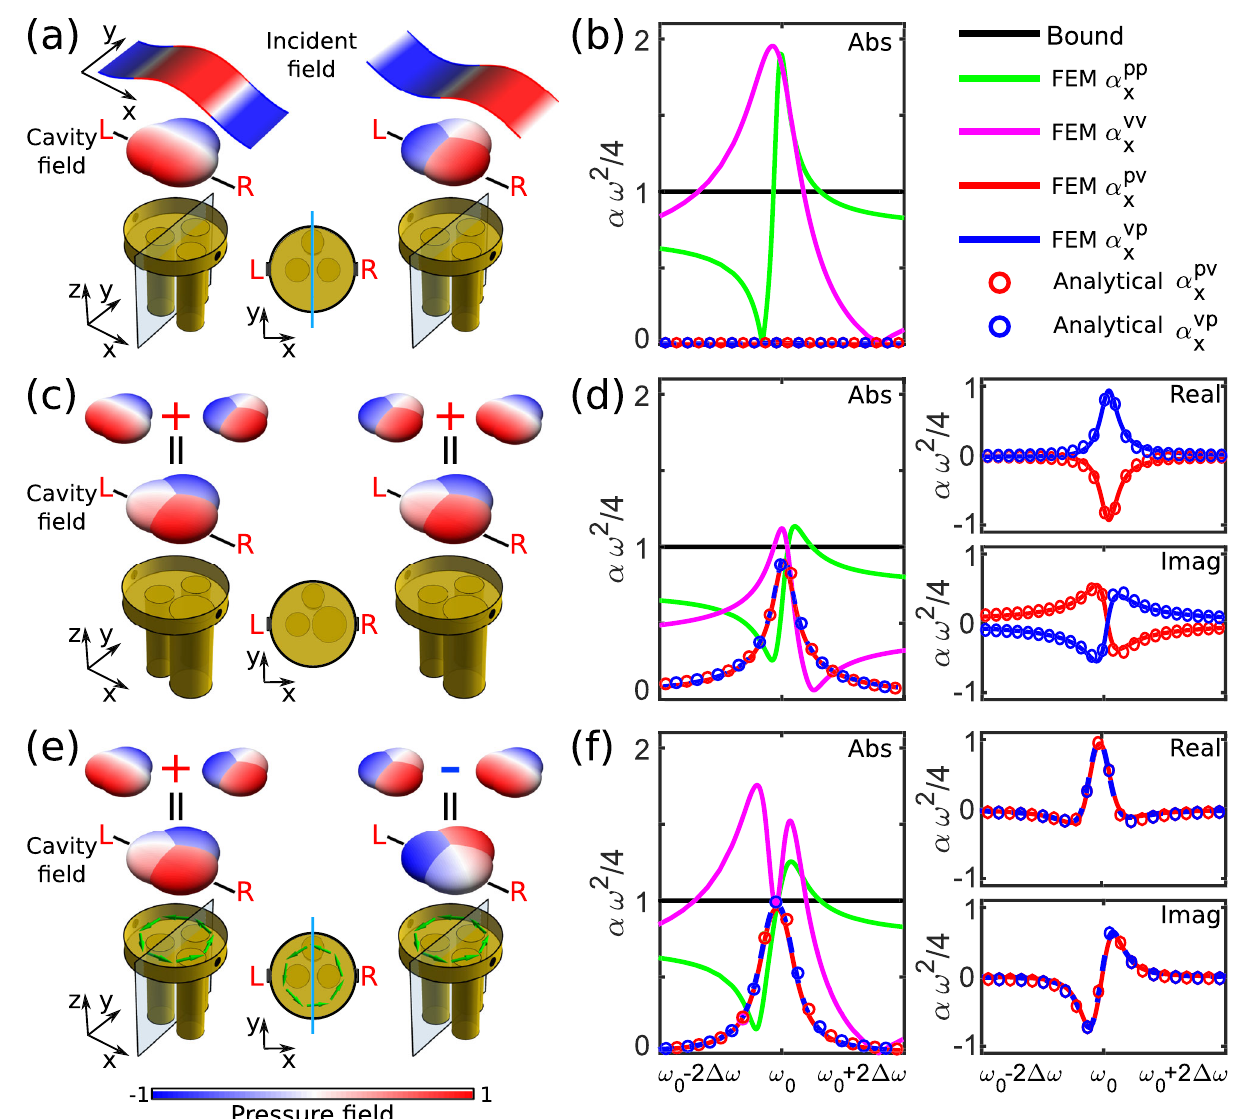
Fig. 1 Even and odd Willis inclusions. a Induced pressure fi eld distribution inside the scatterer for a local pressure (left) and velocity (right) standing wave excitation, in the case of a mirror-symmetric scatterer. The colored blobs here and in the other panels indicate the induced pressure inside each of the cavities loading the scatterer. b Corresponding polarizability dispersion around the resonance frequency. c Similar to A, but for an even Willis scatterer, obeying time-reversal symmetry. The induced fi eld distributions correspond to a superposition of monopolar and dipolar fi elds, yielding identical fi eld distributions for pressure and velocity excitations. d Corresponding polarizability dispersion around the resonance frequency. e Similar to A, but for an odd Willis scatterer, obeying mirror symmetry along the propagation direction, but biased by a rotating fl ow. In this case, the pressure-induced fi elds are identical to the even Willis scenario, but when excited by a velocity fi eld the zero pressure fi elds shift from the left to the right cavity. f Corresponding polarizability dispersion around the resonance